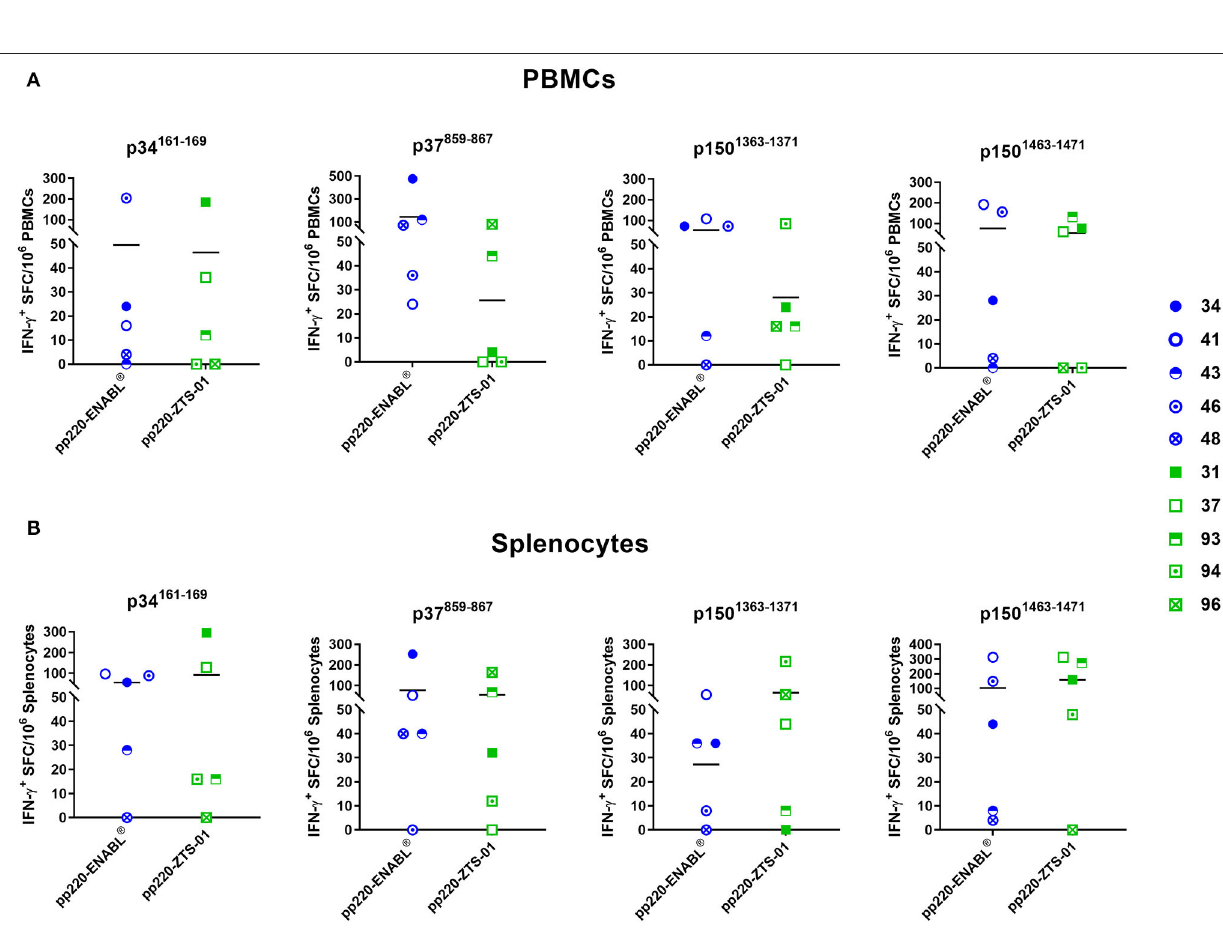
FIGURE 10 | IFN- γ -inducing peptides from ASFV pp220. Four IFN- γ -inducing nanomer peptides from ASFV pp220 that stimulated recall IFN- γ responses in (A) PBMCs or (B) splenocytes isolated from pigs immunized with the Ad-pp220-ENABL ® or the Ad-pp220-ZTS-01 formulation were identified by EliSpot ( Table 3 ). Data for each pig is presented as Spot Forming Cells (SFC)/10 6 PBMCs or splenocytes. Medium alone served as the negative control and the data shown is minus media background counts. Mean responses for the two groups are denoted by